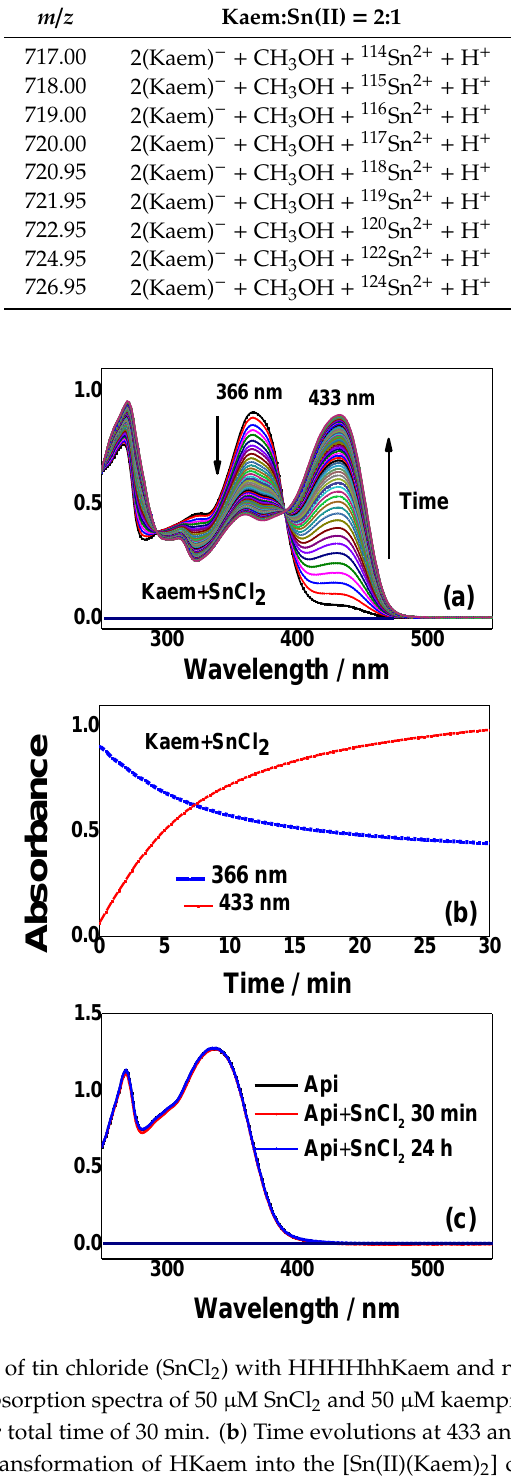
Figure 1. Slow reaction of tin chloride (SnCl 2 ) with HKaem and no reaction of SnCl 2 with apigenin (HApi). ( a ) Absorption spectra of 50 µ M SnCl 2 and 50 µ M kaempferol (HKaem) in ethanol measured every 30 s for total time of 30 min. ( b ) Time evolutions at 433 and 366 nm from Figure 1a corresponding to the transformation of HKaem into the [Sn(II)(Kaem) 2 ] complex. ( c ) Absorption spectra of 50 µ M HApi and solutions of 50 µ M HApi and 50 µ M SnCl 2 in ethanol at 30 min and 24 h after